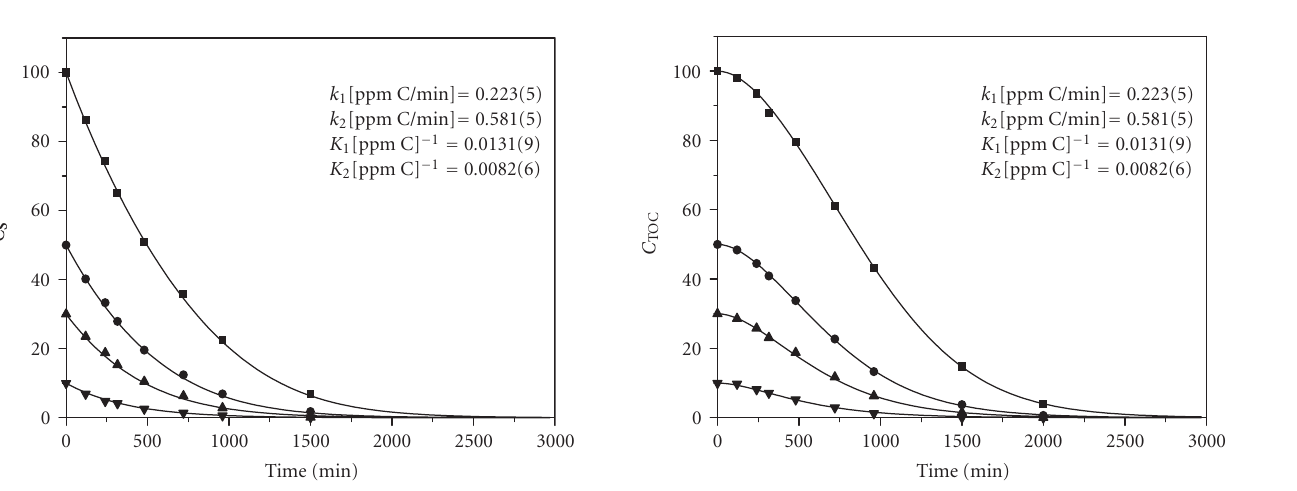
Figure 1: Kinetics of disappearance of methane, as substrate, from the gas phase, with 0.30 W · cm − 1 of absorbed radiation power per unit membrane length. Concentrations, C S in mg/L, for methane, are expressed as carbon, which was not transformed into interme- diates, as a function of time, expressed in minutes, as time necessary to treat 1L of gas phase. Photocatalytic membranes used in these experiments did not contain any photopromoting agent.